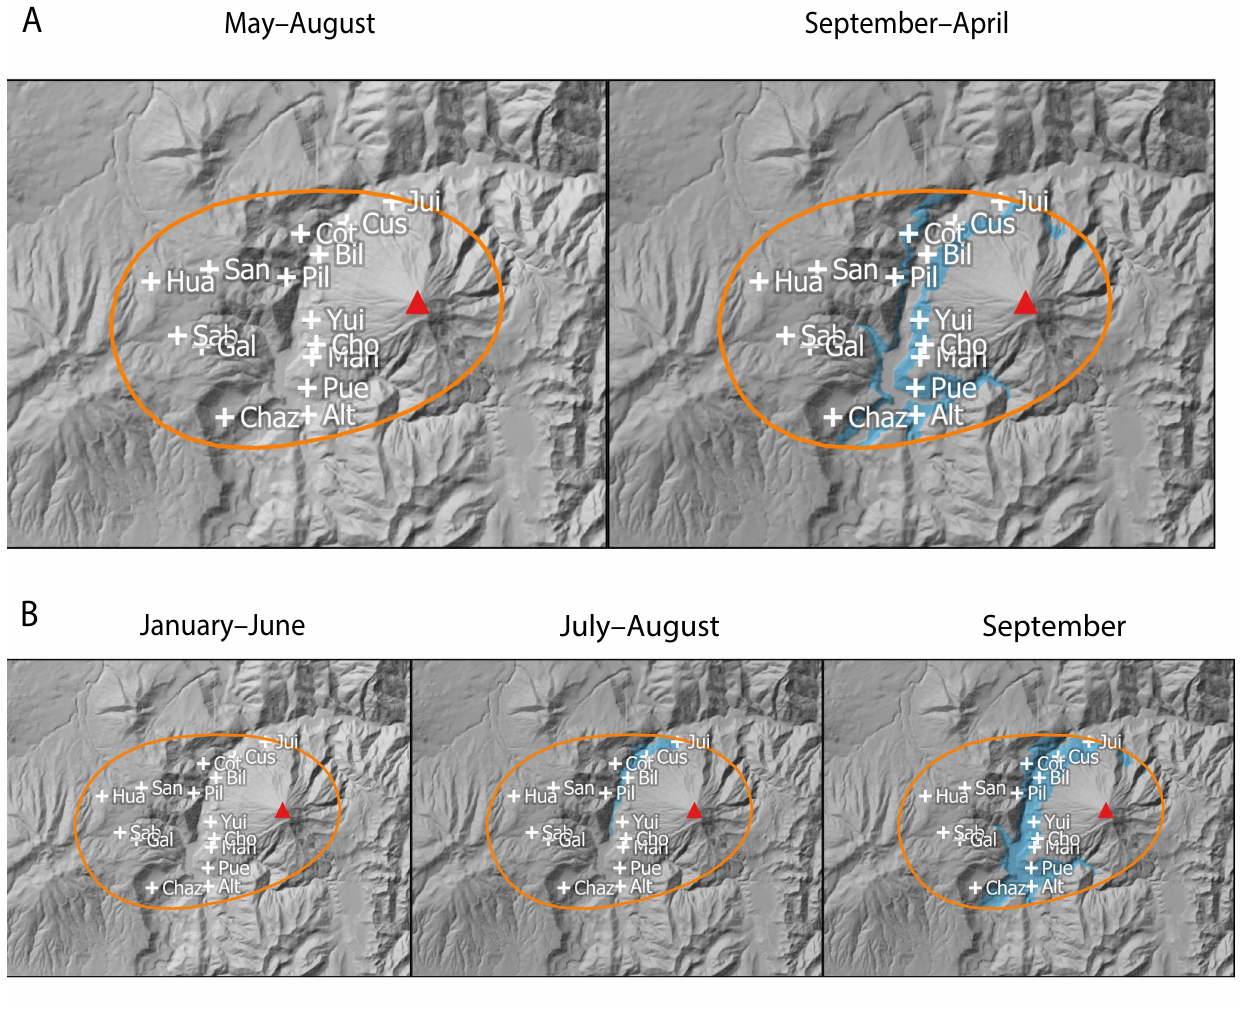
Figure 7: Maps illustrating the spa- tial variation in crop vulnerability to tephra throughout the year within the surveyed area (delineated by the orange line): fruit trees (e.g. ap- ple, greengage, peach, and pear) [A] and corn [B]. The area across which the crop is vulnerable to tephra is coloured in blue. See text for expla- nations. Symbols and village names as in Figure